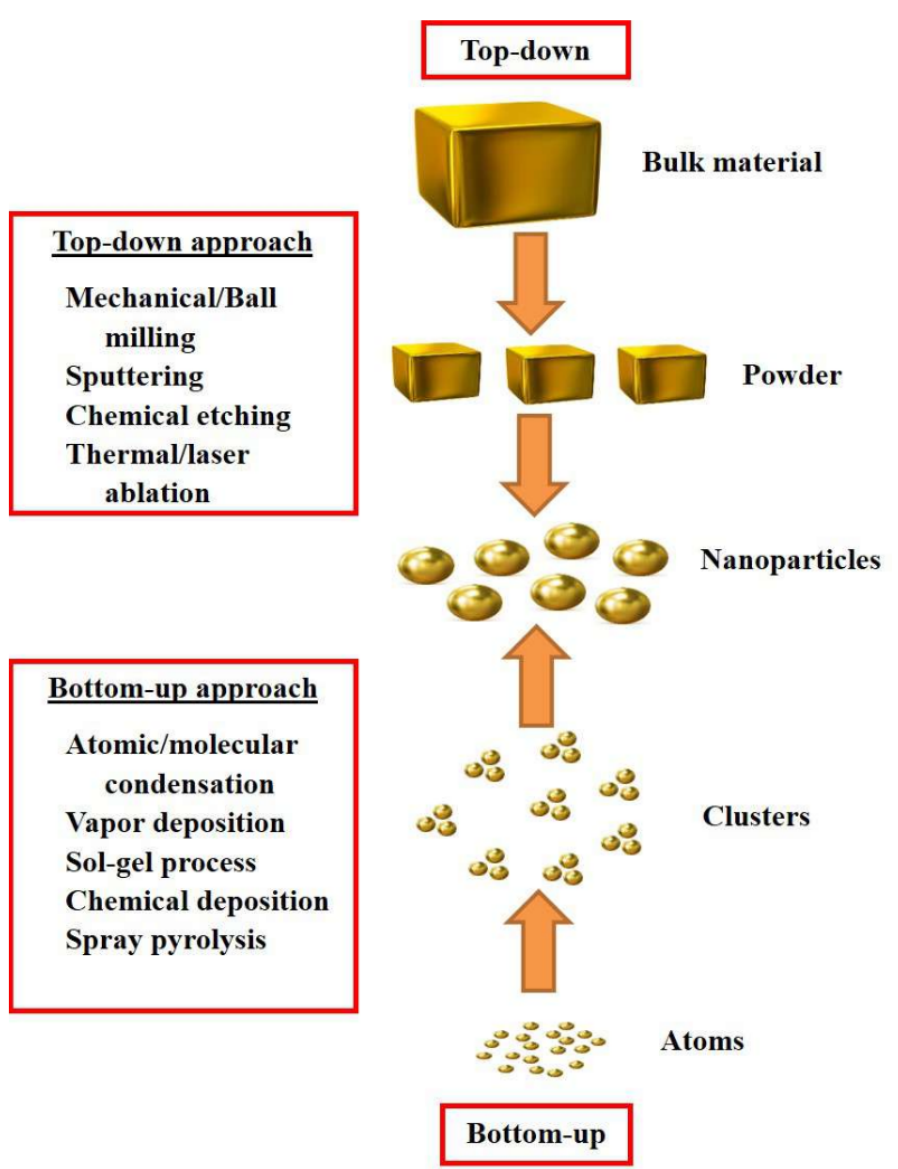
Figure 2. Top-down and bottom-up approaches for nanoparticles